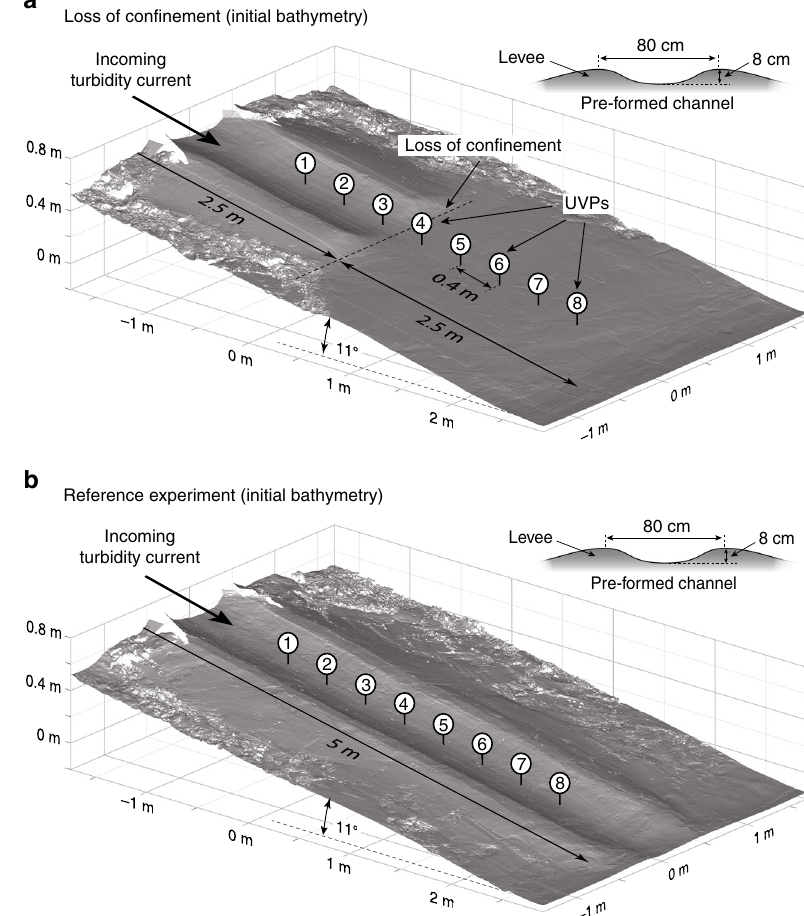
Fig. 2 Digital-elevation-models of the initial bathymetry. a The fl ume experiment with loss of con fi nement. The loss of con fi nement was generated by a decrease of the levee height 2.5 m downstream of the inlet box. b The reference fl ume experiment with a continuous pre-formed channel over the entire length of the slope. The substrate in both experiments was equivalent to that of the sediment mixture used to generate the turbidity currents. The channel dimensions, as well as the input conditions of the incoming turbidity current, were identical in both experiments. UVP Ultrasonic Velocimetry